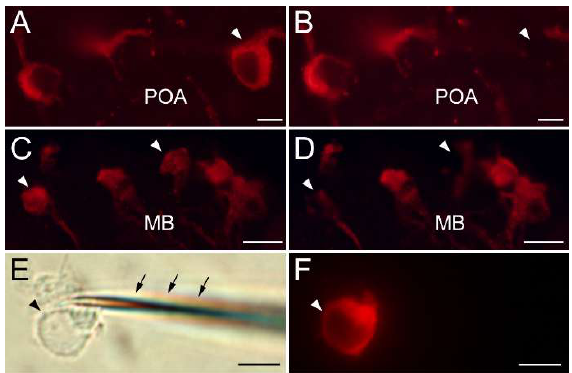
Figure 2. Photomicrographs of harvesting of Cy3-labeled immunofluorescent GnRH neurons. ( A , B ) GnRH1 neurons in the preoptic area (POA); ( C , D ) GnRH2 neurons in the midbrain (MB); ( E , F ) GnRH3 neurons in the terminal nerve. Arrows indicate the GnRH cells before ( A , C ) and after ( B , D ) harvesting. Scale bars = 20 μm.